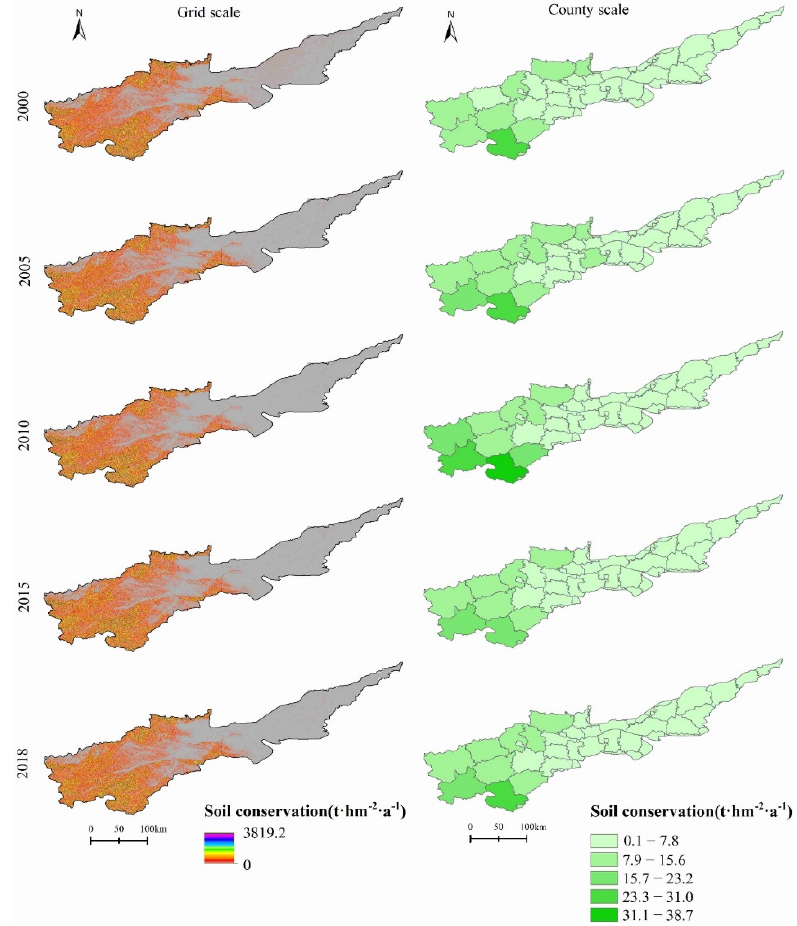
Figure 4. Spatiotemporal distribution patterns of soil conservation amount in the AYRHP on grid and county scales.